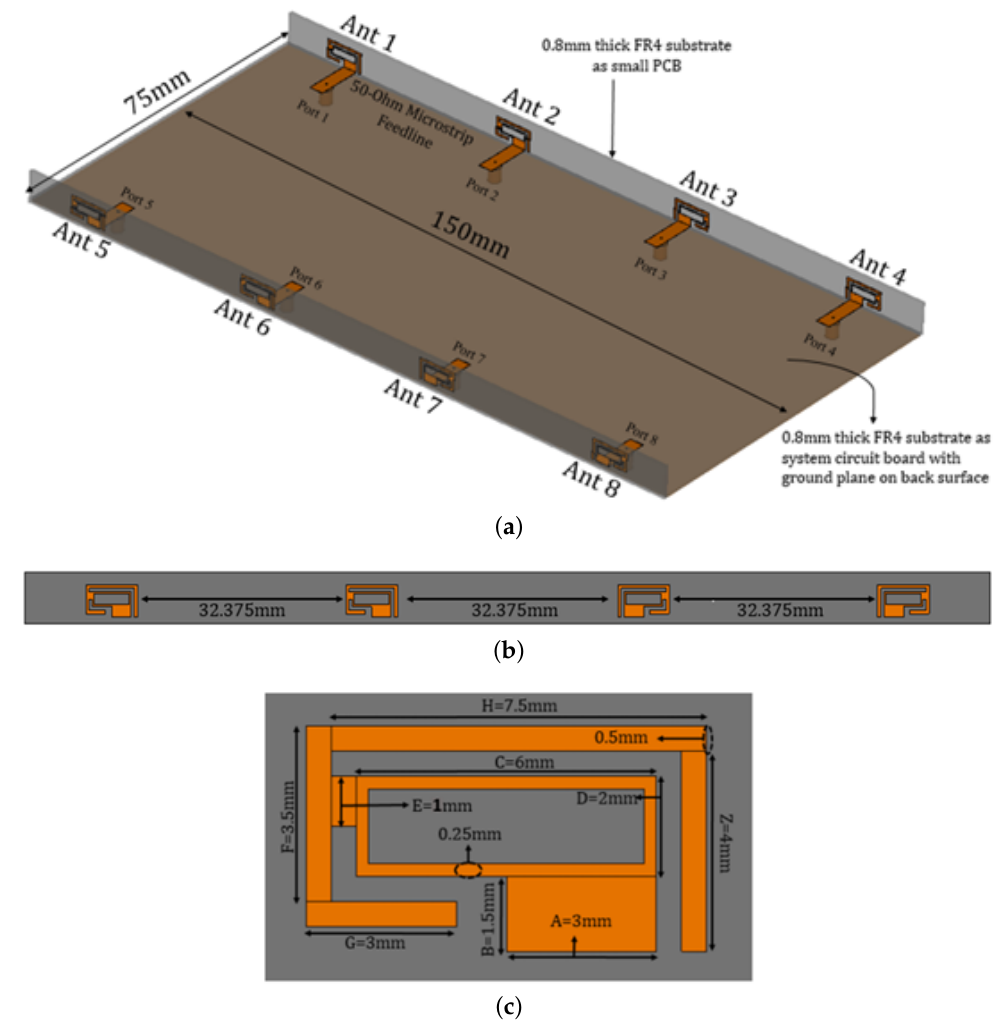
Figure 1. Proposed MIMO Antenna System. ( a ) Perspective view; ( b ) sub-array designed on side-edge frame; ( c ) single antenna